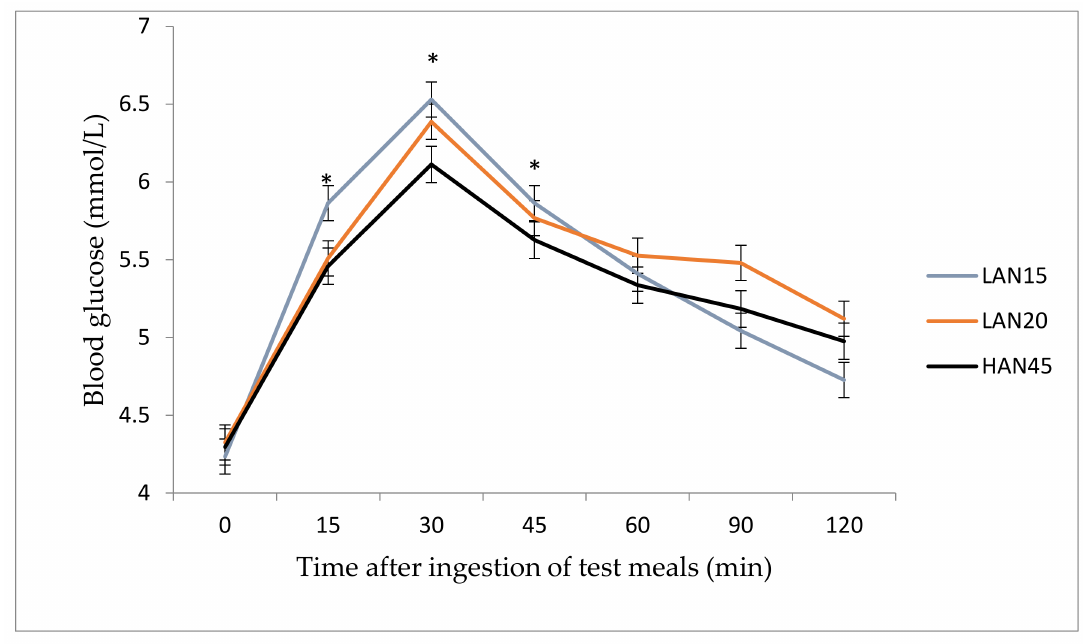
Figure 2. P1 study: The e ff ects of consuming noodles containing 15%, 20% and 45% amylose on postprandial glycaemia at di ff erent time periods over 120 min. High amylose noodles (45%) induced significantly lower blood glucose at 15, 30 and 45 min ( p = 0.027). Values presented as mean ± SEM. * indicates statistical significance ( p <